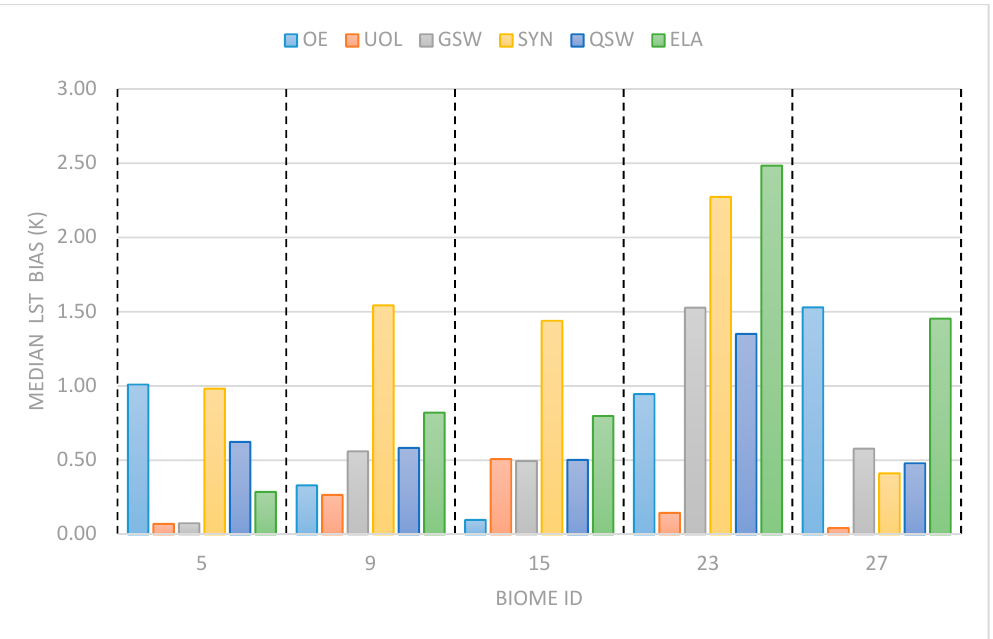
Figure 8. The median LST biases for each of the TIR algorithms for the five most frequent biomes in the dataset. ( 5 ) closed to open broadleaved evergreen and/or semi-deciduous forest; ( 9 ) open needleleaved deciduous or evergreen forest; ( 15 ) sparse vegetation; ( 23 ) bare areas of soil type Aridisols—Calcids; ( 27 ) permanent ice